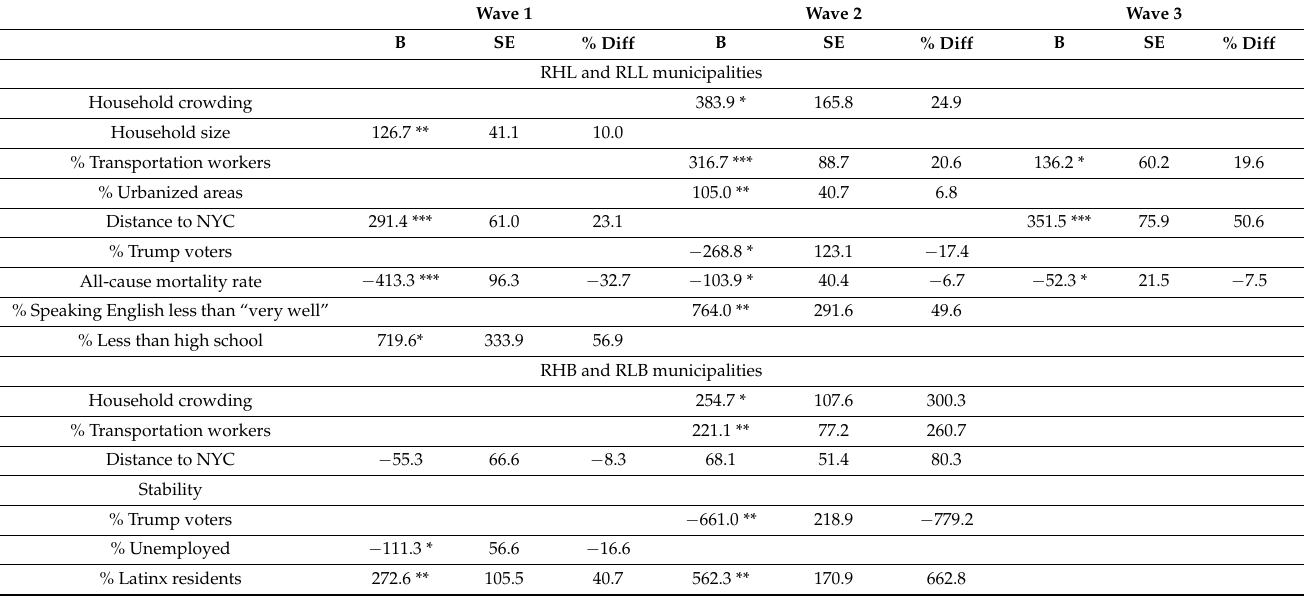
Table A3. Robustness tests with 20% Latinx/Black residents as group cutoffs.